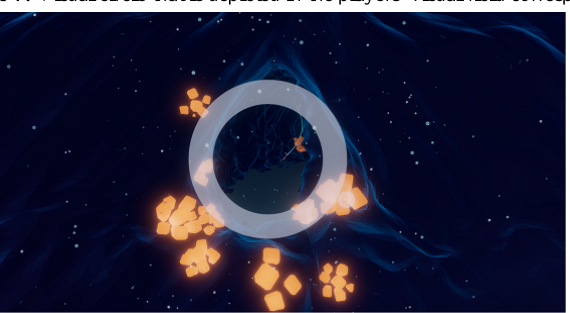
Figure 1. Visual circle that is depicted in the players’visual field corresponding to an inhalation (left) and exhalation peak